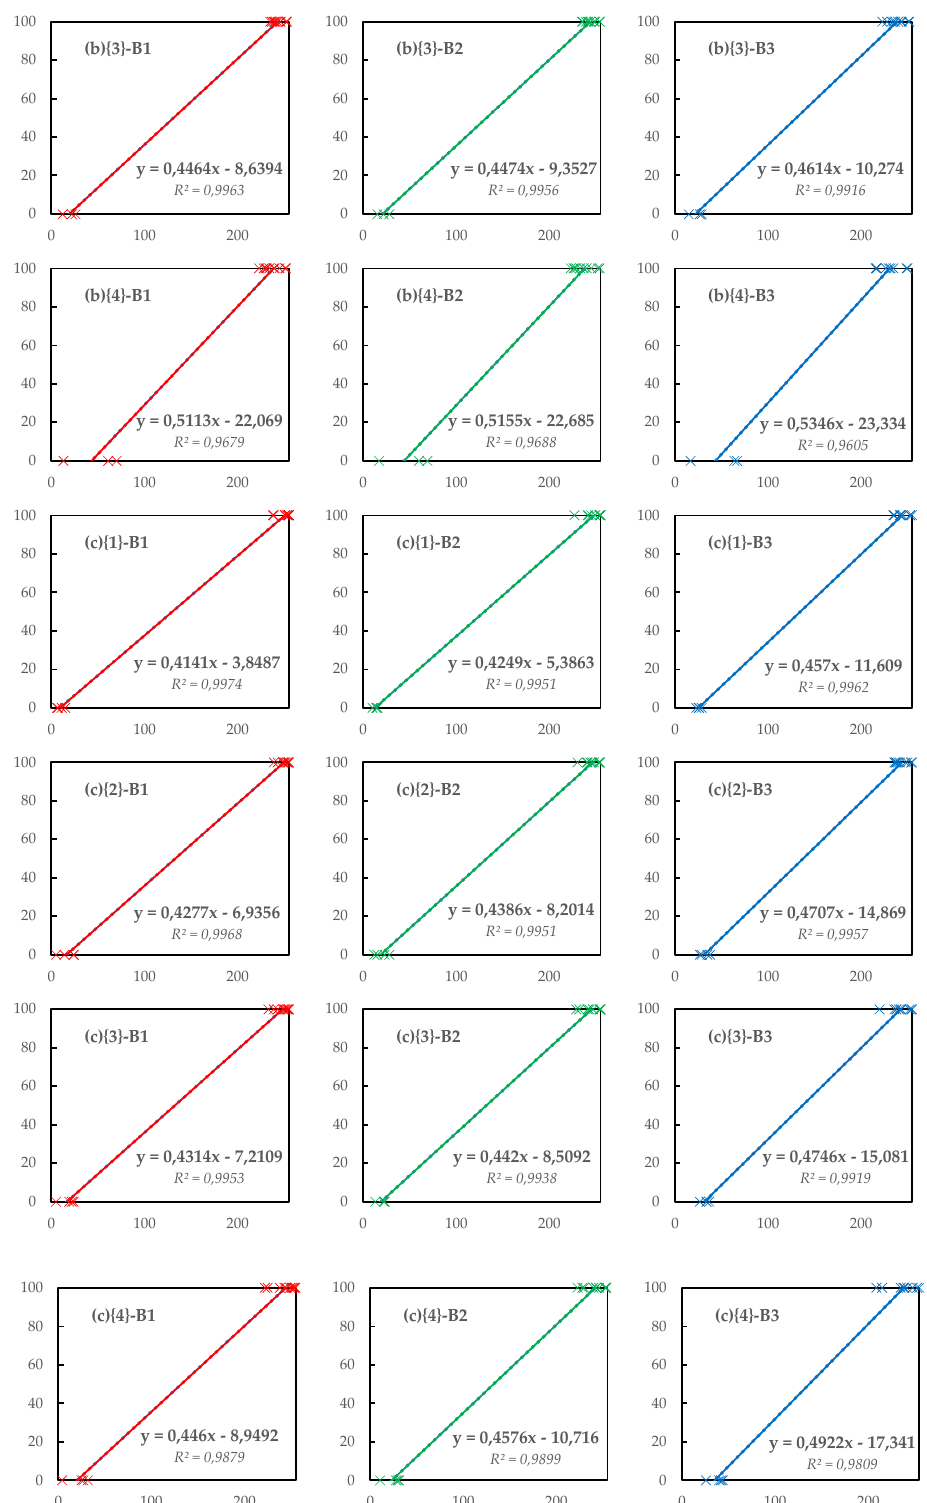
Figure 3. Regression lines obtained by applying ELM: DNs values in abscissa related to percentage reflectance values inordinate. Scenarios ( a ), ( b ) and ( c ) are represented in spatial resolutions {1}, {2}, {3} and {4} in the three bands (B1, B2, B3), red, green and blue respectively. In each graph, the regression equation and the coefficient of determination R 2 can be observed.